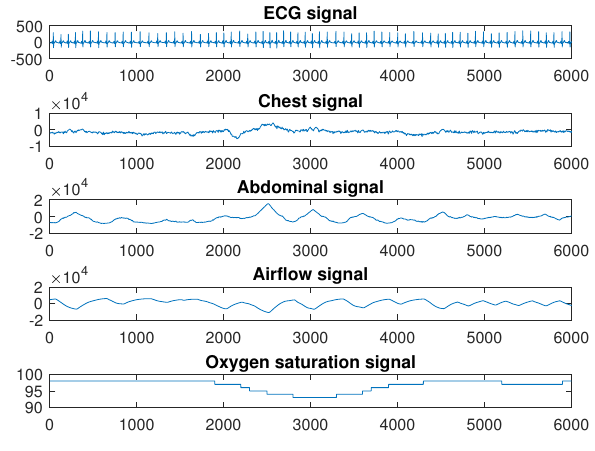
Figure 1. Example of one minute Polysomnography (PSG)